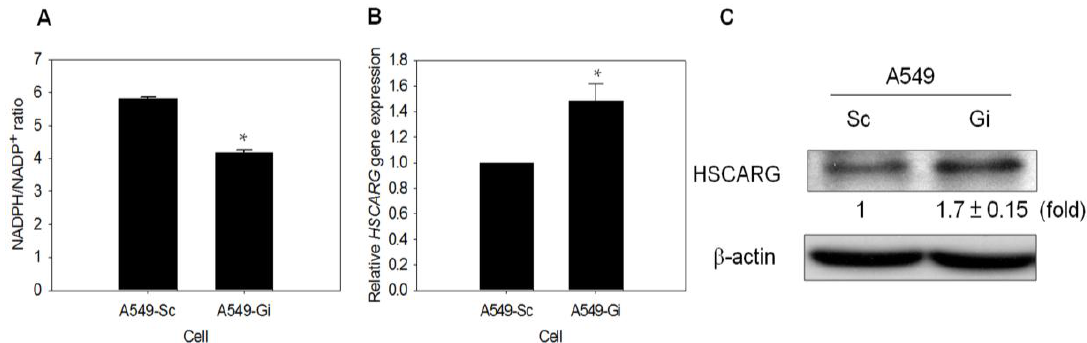
Figure 5. Expression of HSCARG increases in G6PD -knockdown A549 cells. ( A ) NADPH and NADP + content were determined by UPLC, and NADPH/NADP + ratio was calculated. * p < 0.05 as compared to A549-Sc cells; ( B ) The level of HSCARG mRNA was determined in A549-Sc and A549-Gi cells by quantitative-PCR. The level of HSCARG gene expression was normalized to that of A549-Sc cells. * p < 0.05, as compared to A549-Sc cells; ( C ) HSCARG protein in A549-Sc and A549-Gi cells was quantified by western blotting, and β -actin serves as internal control. The relative change in HSCARG protein level is shown as compared to A549-Sc cells. Numbers shown below the upper panel indicate the fold change in HSCARG expression relative to that of Sc cells.